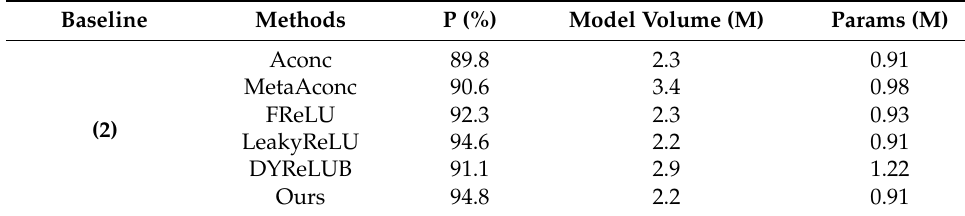
Table 10. The ablation study of ReLU on the SSDD dataset.